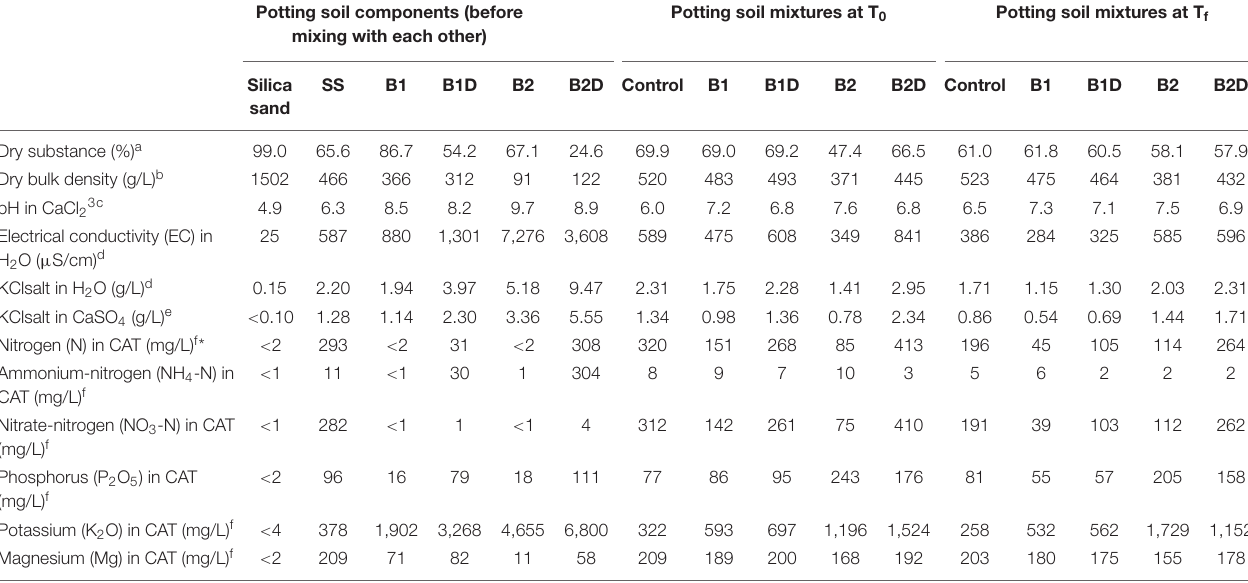
TABLE 2 | Main physical-chemical traits of the single separated potting soil components [silica sand, soil substrate (SS), wood chip biochar (B1), B1 incubated with digestate (B1D), wheat straw biochar (B2), and B2 incubated with digestate (B2D)] before mixing (on the left); and of the potting soil mixtures of the control and all treatments at the beginning (T 0 ) and at the end (T f ) of the experiment (respectively, in the center and on the right). Potting soil components (before Potting soil mixtures at T mixing with each other)